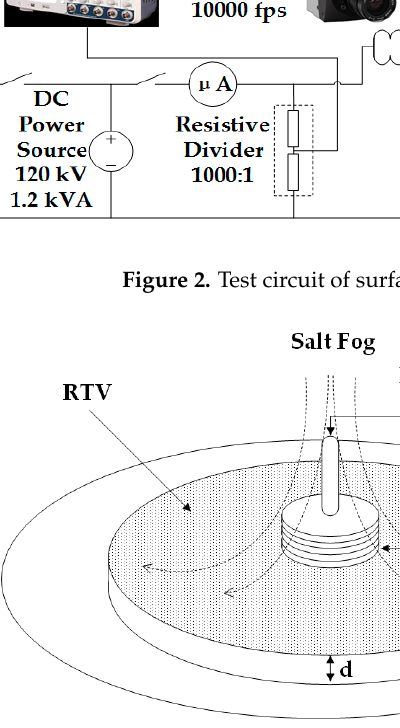
Figure 3. The discharge model of Room Temperature Vulcanized (RTV)-coated surface.